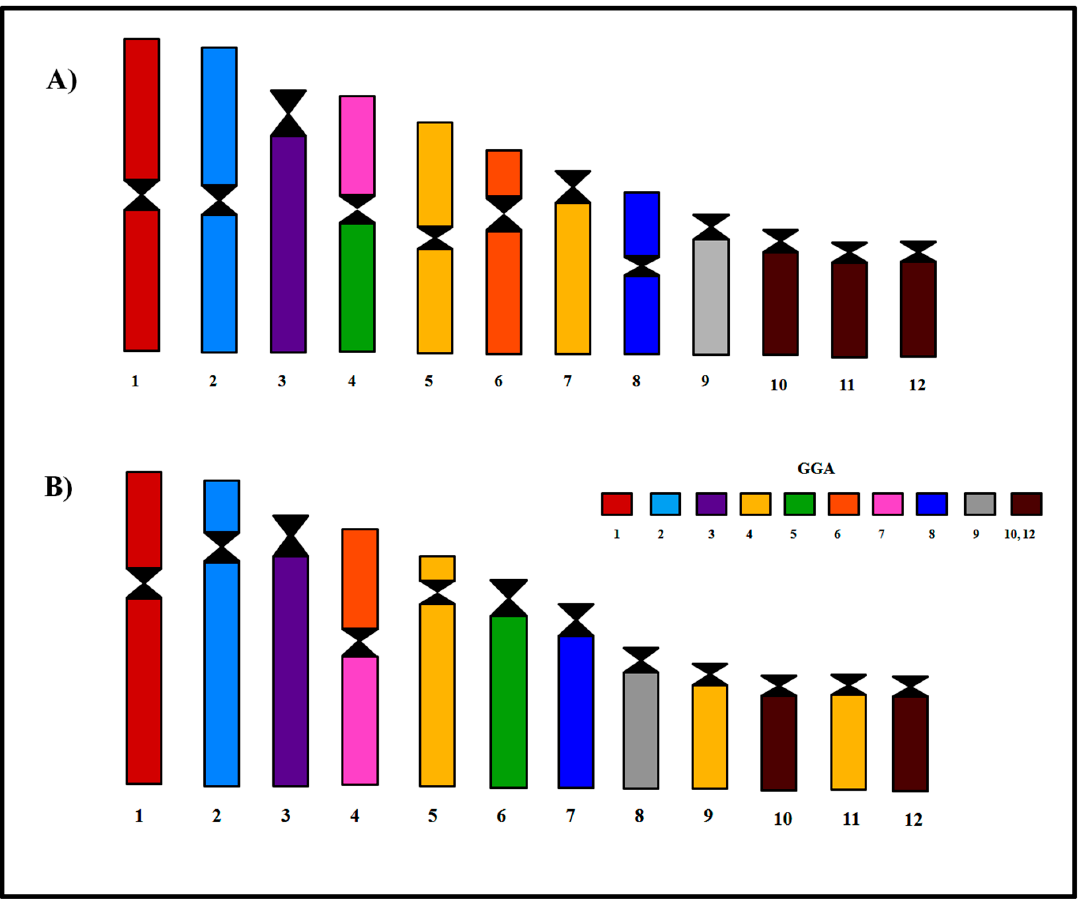
Figure 4. Homology maps with GGA probes in ( A ) Aramides cajaneus and ( B ) Psophia viridis